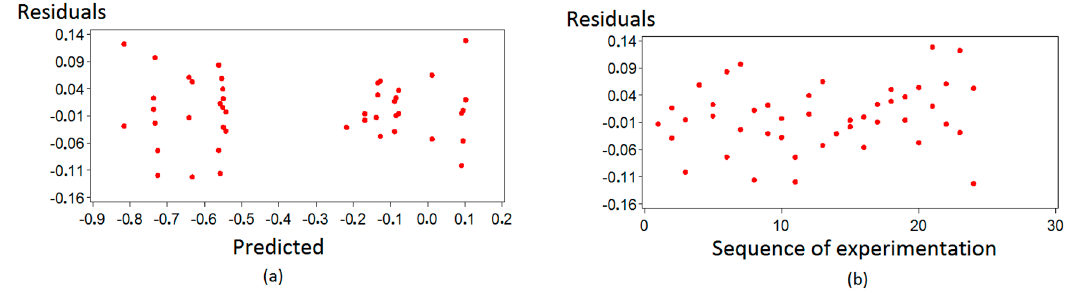
Figure 7. Checking of ( a ) the homocedasticity hypothesis and ( b ) the non-existence of patterns on